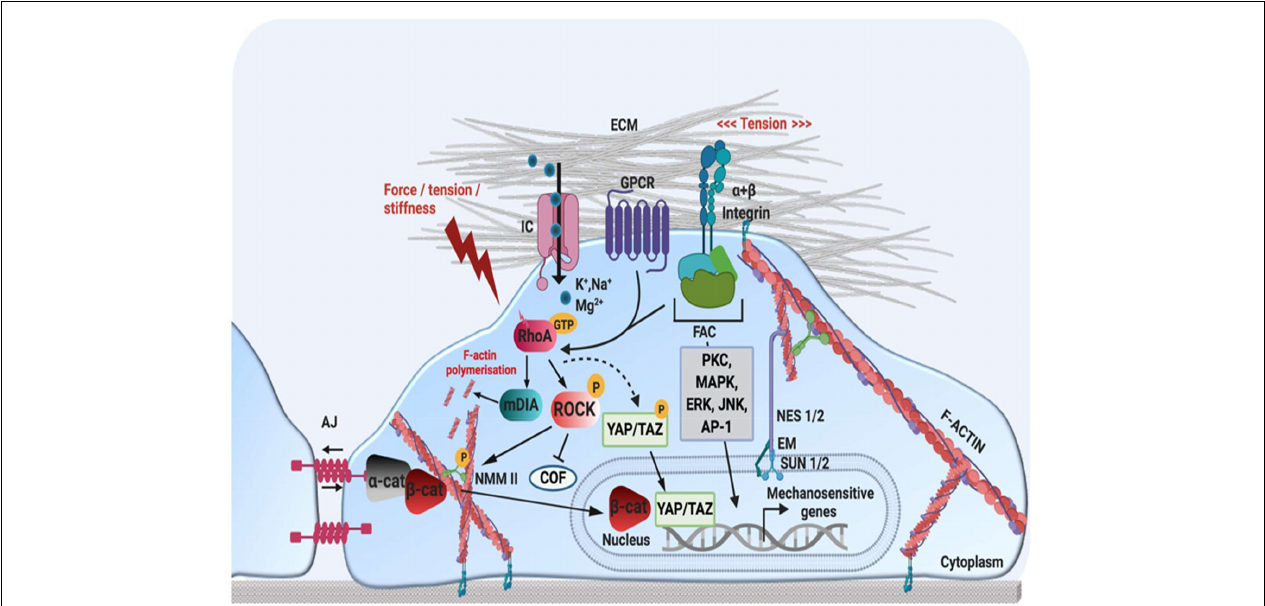
FIGURE 3 | Schematic representation of mechanotransduction pathways. Mechanical stimuli are perceived by mechano-sensors at the cellular-ECM interface, such as integrin-FA complexes, GPCR, AJ and stretch-activated ion channels. This activates several cellular signalling pathways involving kinases or transcription factors (MAPK, ERK, JNK, PKC, AP-1), as well as Rho small GTPases (RhoA). RhoA-GTP regulates actin structure by (1) activating mDia to promote actin polymerisation (2) activating ROCK, which enhances actin contractility by activating NMM II phosphorylation, and (3) preventing actin disassembly by inhibiting the actin-severing protein COF. The remodelling of F-actin and increased cytoskeletal tension also regulates YAP/TAZ, which translocate to the nucleus in response to mechanical strain. At AJ, cadherin-actomyosin connections form via α -cat and ß-cat. An increase in tension at cell-cell contacts induces unfolding of α -cat, which promotes recruitment of AJ-stabilisation proteins such as vinculin. In response to a loss of cell-cell adhesion or mechanical stimulation, ß-cat can translocate to the nucleus, to activate mechanosensitive genes. Nuclear mechano-transduction occurs via the LINC complex, which directly couples the nuclear envelope to the cytoskeleton. NES 1/2 form a link between actin and SUN 1/2 proteins in the perinuclear space, which interact with the nuclear lamina via EM and lamin A. Nesprin proteins also connect the nuclear lamina with intermediate filaments and microtubules (not depicted here). JNK, c-Jun N-terminal kinase; PKC, protein kinase C; AP-1, activator protein 1; FAC, focal adhesion complex; GCPR, G-protein coupled receptor; IC, ion channel; ECM, extracellular matrix; AJ, adherens junction; α -cat, alpha-catenin; ß-cat, beta-catenin; YAP, yes associated protein; TAZ, WW domain-containing transcription regulator protein 1 NES 1/2, nesprin-1/2; SUN 1/2, sun-domain containing protein 1/2; EM, emerin; AP-1, activator protein 1; ERK, extracellular-receptor kinase; ROCK, rho-associated protein kinase; RhoA, ras homolog family member A; COF, cofillin; NMM II, non-muscle myosin II. Created using